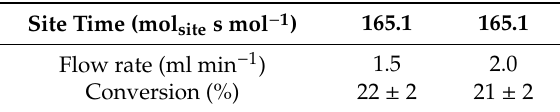
Table 5. Conversion of two di ff erent aldol reaction experiments using hexane as solvent with an identical site time but di ff erent feed flow